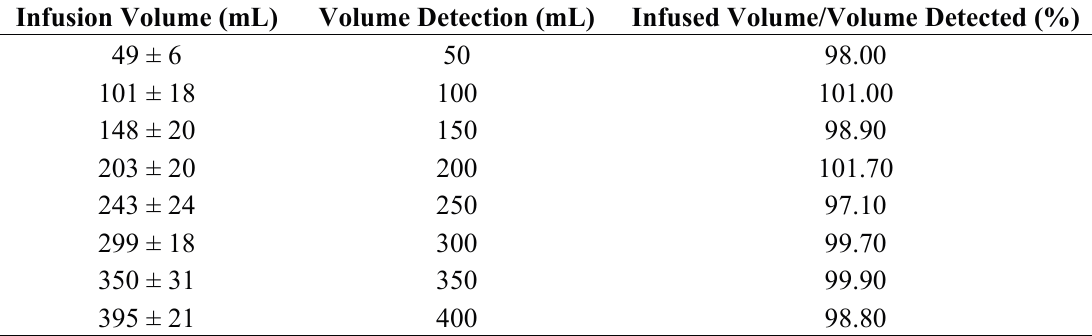
Table 2. Accuracy of volume detection by the potentiometric